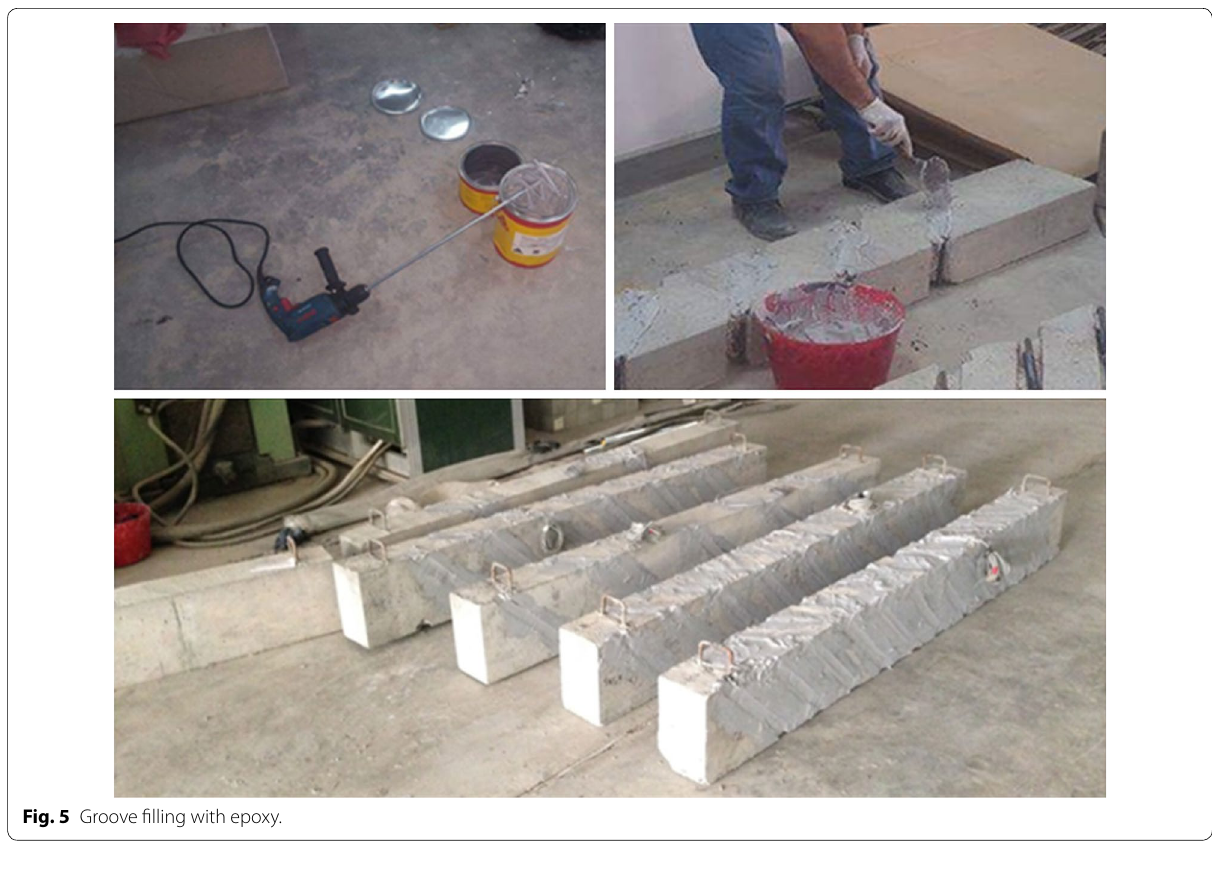
Fig. 5 Groove filling with epoxy.